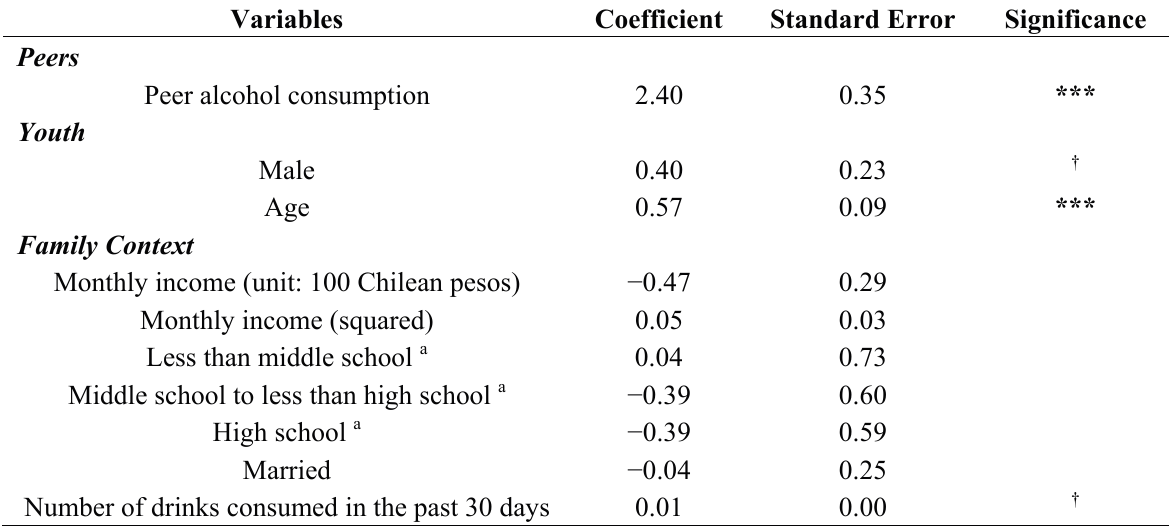
Table 2. Relationship between Peer-Drinking and Youth-Drinking under Homogeneity Assumption ( N =